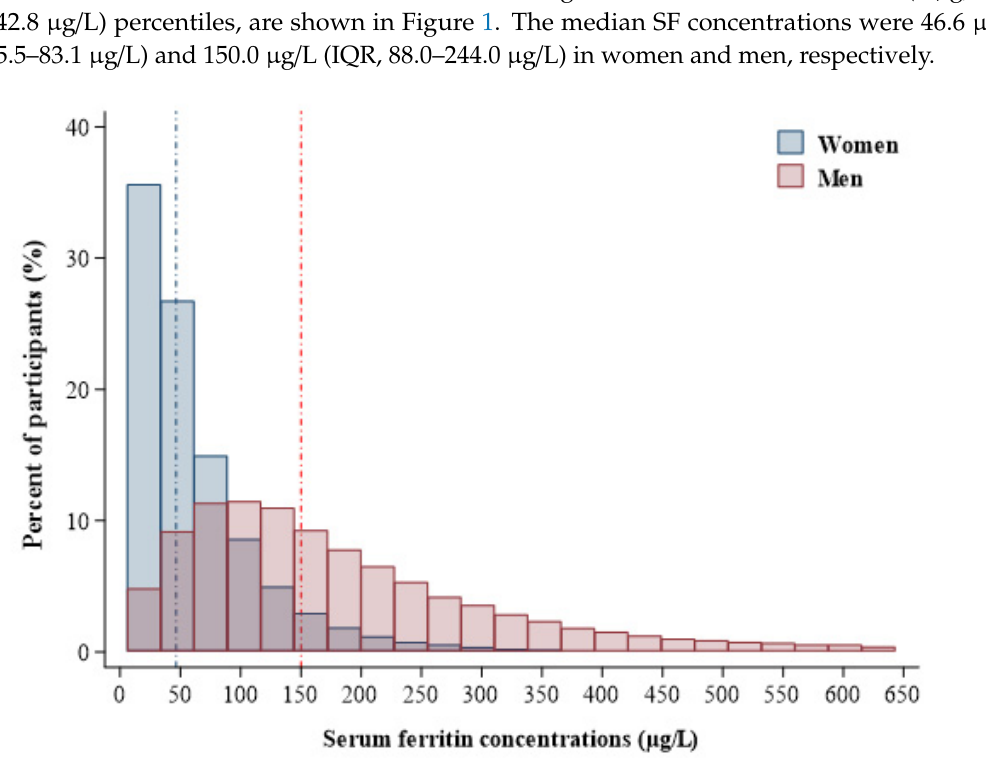
Figure 1. Frequency distribution of serum ferritin concentrations in men (red area) and women (blue area). Vertical lines represent the medians of serum ferritin levels in men (red line; serum ferritin = 150 µ g / L) and women (blue line; serum ferritin = 46.6 µ g / L), and the box is truncated at the 1st (6 µ g / L) and 99th (642.8 µ g / L)